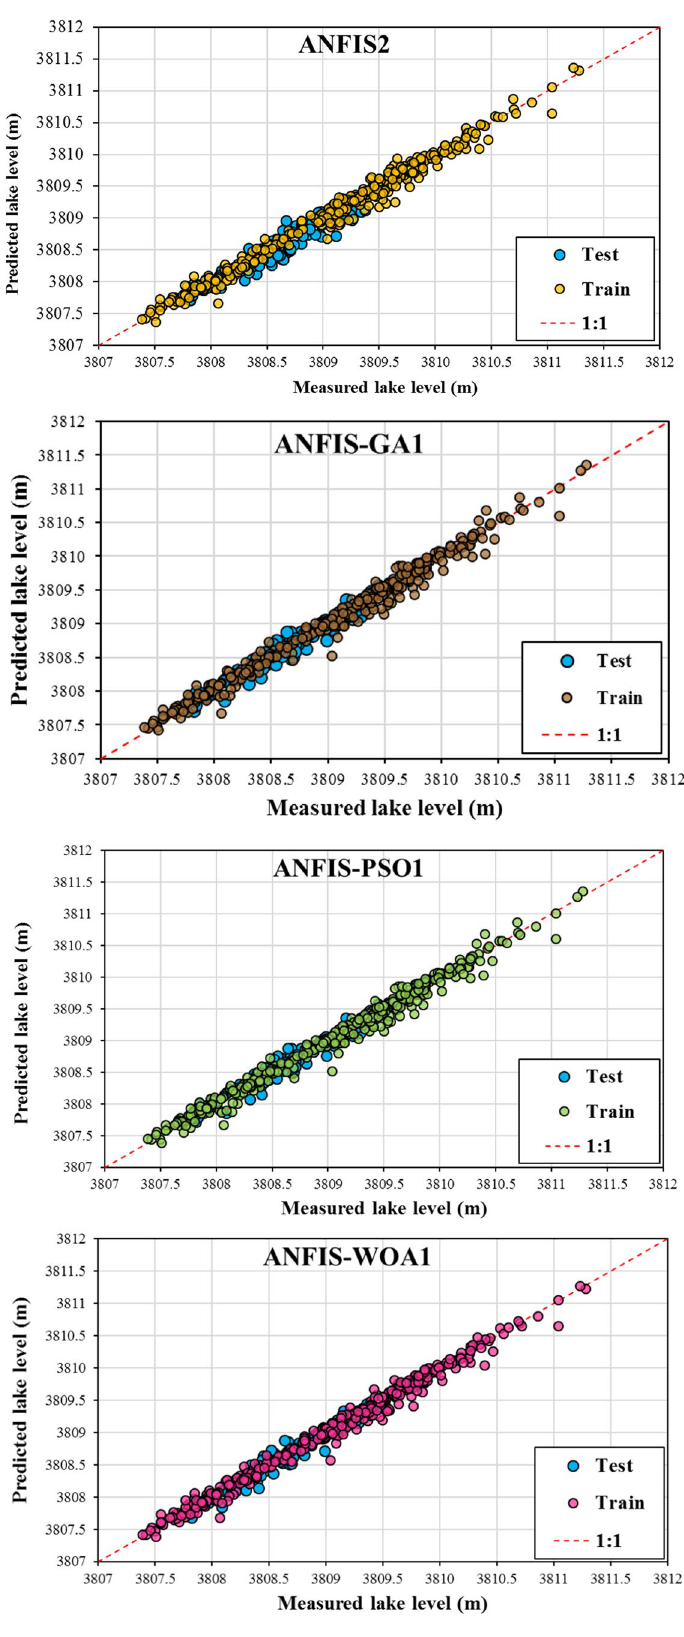
Fig. 6 Scatter plot of measured- predicted Titicaca water level for best scenario of each